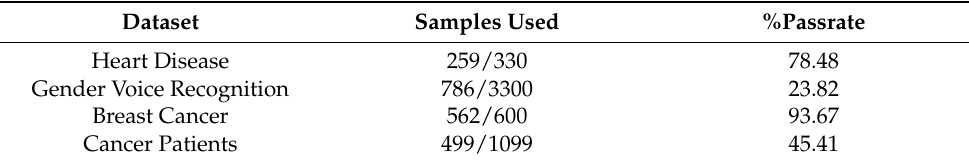
Table 5. Datasets sample status after PCA–sample reduction process.